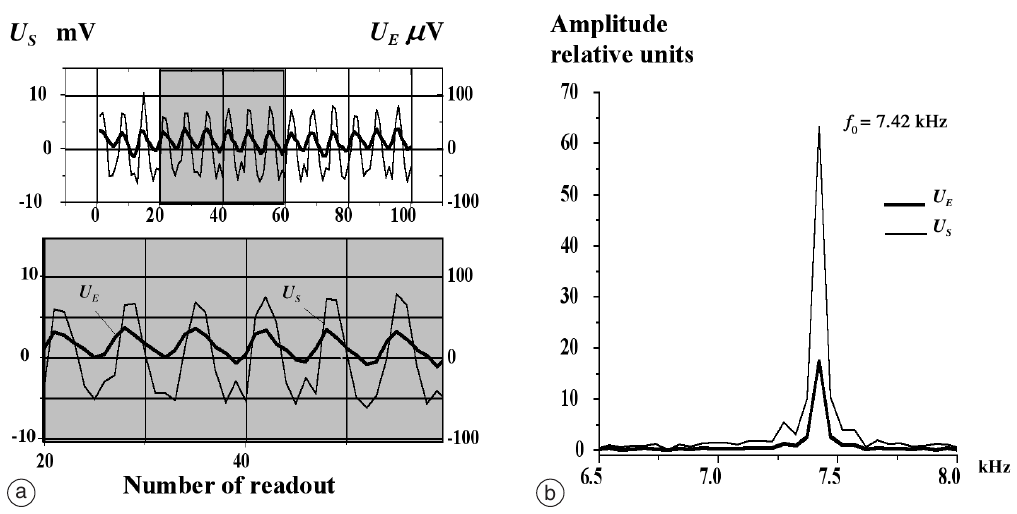
Fig. 6a,b. MSO of the first type ( E = 9 v/cm): a) electric ( U E ) and acoustic ( U S ) signals; b) spectra of the sig- nals U E and U S .